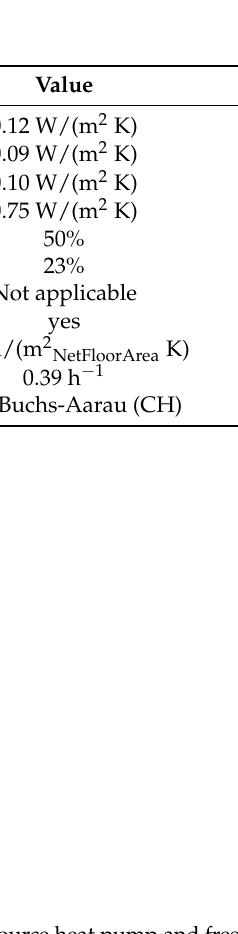
Figure 1. Monthly and annual mean source temperatures for ground-source heat pump and fresh- water.